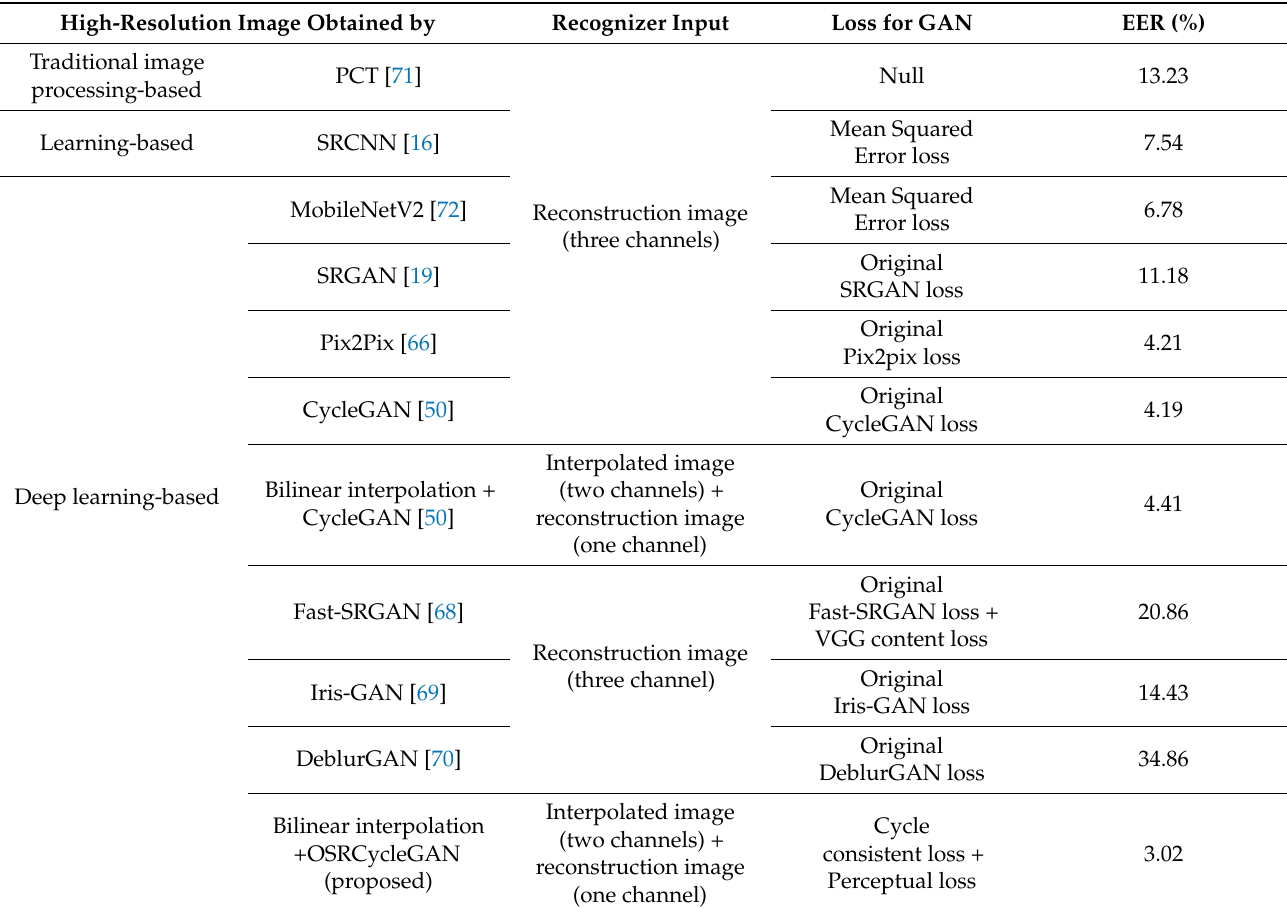
Table 8. Comparisons with the state-of-the-art methods with CASIA-Iris-Distance database (using bilinear interpolation + Gaussian blurring when generating a low-resolution image). For the training of recognizer, train from scratch was used.